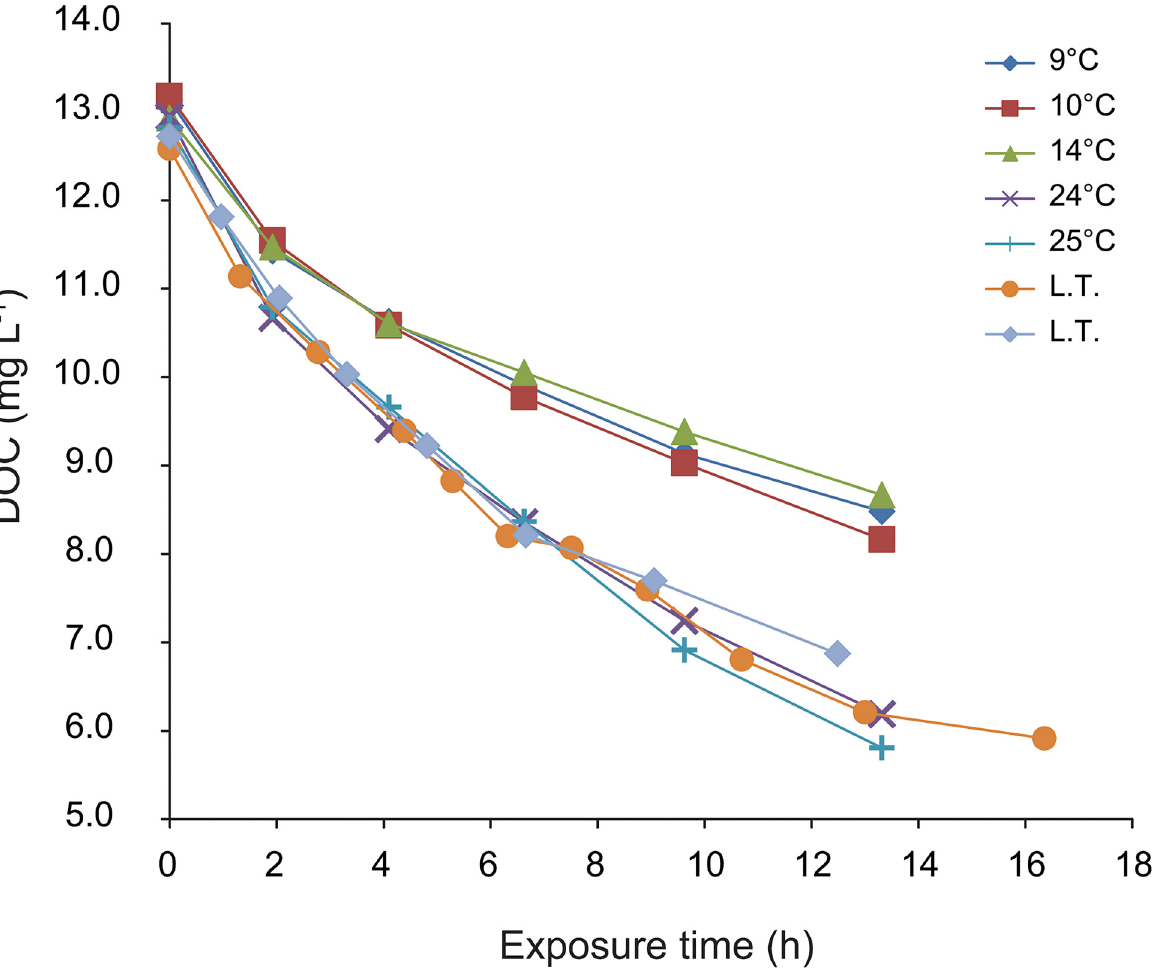
Fig 3. Changes in DOC concentration during irradiation experiments at different temperatures. L.T. – laboratory temperature, approximately